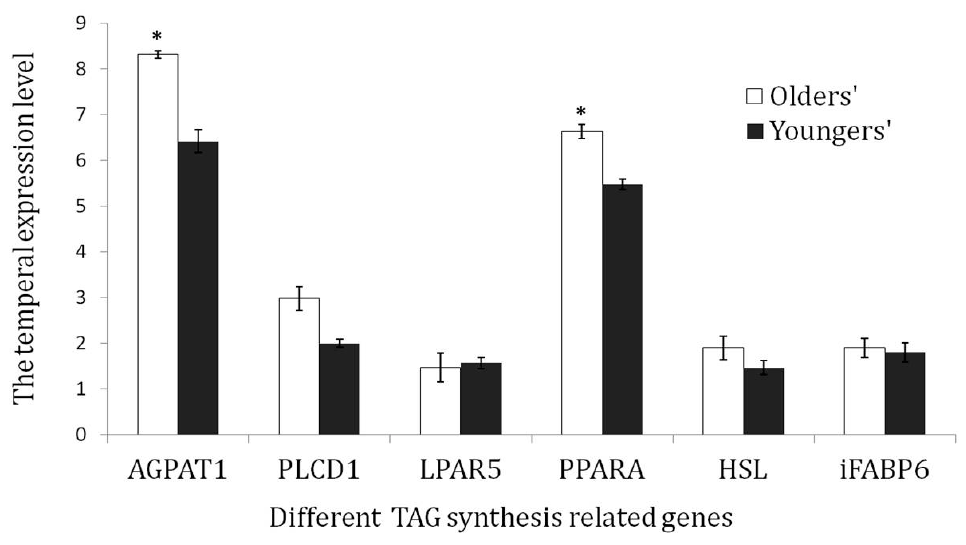
Figure 6. qRT-PCR validation of TAG-related genes. Six genes were selected as representatives of the older and the younger groups. AGPAT1: 1-acylglycerol-3-phosphate O-acyltransferase 1, PLCD1: phospholipase C delta 1transcript variant 1, LPAR5: lysophosphatidic acid receptor 5, PPARA: peroxisome proliferator-activated receptor alpha, HSL: hormone-sensitive lipase, iFABP6: ileal-type fatty acid-binding protein 6. β -actin was used as the internal control, and each value represents an average of three separate biological replicates. Blood was sampled from the same six individuals as for transcriptome analysis. The error bars represent the standard deviation. Asterisk (*) marks significant difference, set at p = 0.05 with a t